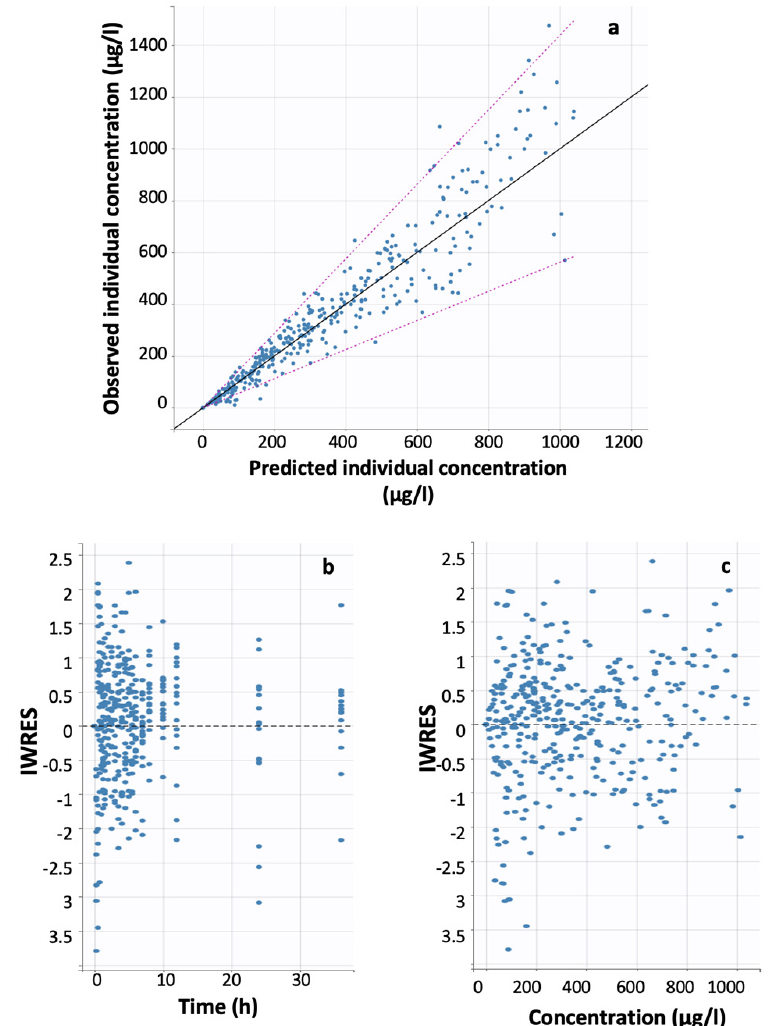
Figure 2. Goodness-of-fit plots for the final best model: ( a ) Observed vs. predicted by the model individual concentrations of amisulpride. The closed circles refer to the (predicted, observed) pairs, the solid line expresses the ideal situation of unity (i.e., y = x), while the dotted lines show the 90% prediction interval; ( b ) Individual Weighted Residuals (IWRES) versus time; and ( c ) IWRES versus concentration. The dotted line (for plots ‘b’ and ‘c’) represents the ideal situation of y =